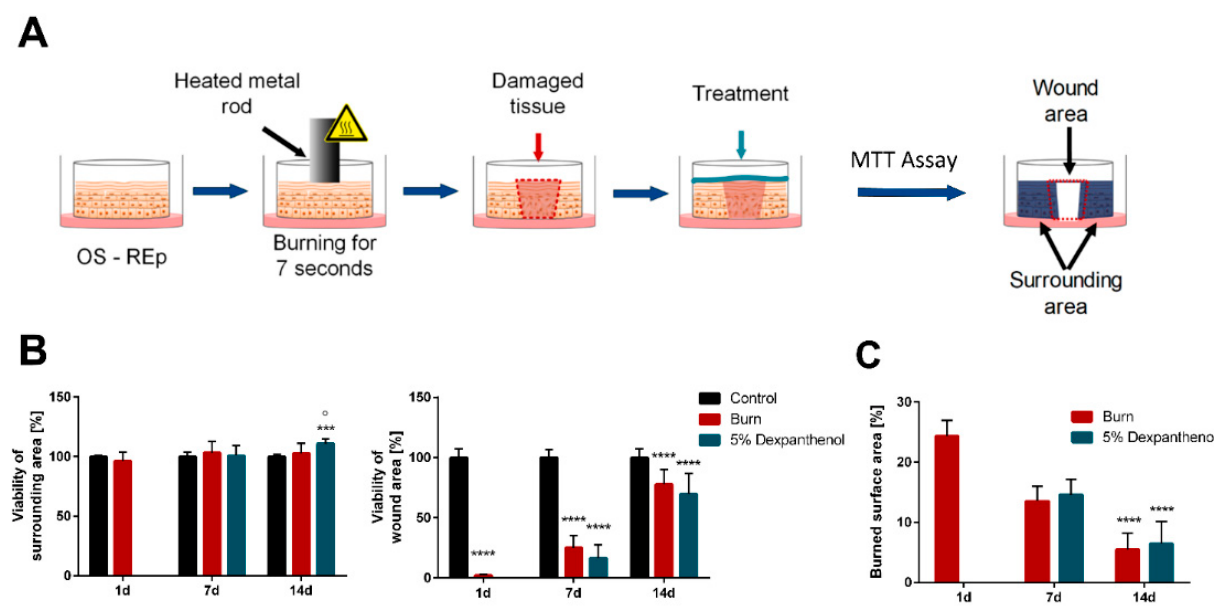
Figure 1. Generation of burn wounds in reconstructed human epidermis and analysis of viability. ( A ) Schematic overview of the burning process. Models were burned on day 12 of culture by contact with a preheated metal rod for seven seconds. Wound healing and viability were monitored for 14 days, with one experimental group being treated by topical application of 5% dexpanthenol. ( B ) Viability in percentage normalized to the unwounded control group. Viability was measured for burned and surrounding area separately. Viability of surrounding tissue showed significant differences for the group treated with 5% dexpanthenol on day 14 after burning. Wounded area showed significantly decreased values of viability on all days for burned models and models treated with dexpanthenol. (3 biological replicates in independent test runs with 3 technical replicates each; mean values ± SD; 2way ANOVA with Tukey’s multiple comparisons test, *** p < 0.001, **** p < 0.0001 compared to the control. ° p < 0.05 compared to burned models). ( C ) Evaluation of burned surface area showed decreasing wound area with significantly lower values on day 14. (3 biological replicates in independent test runs with 3 technical replicates each; mean values ± SD; Kruskal-Wallis test with Dunn’s multiple comparisons test, **** p < 0.0001 compared to the initial burned area on day 1).